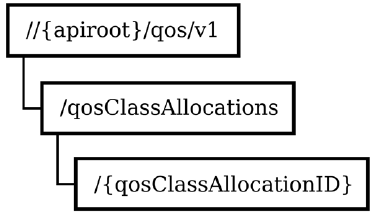
Figure 6. Structure of resource URIs related to the QoS class negotiation function.